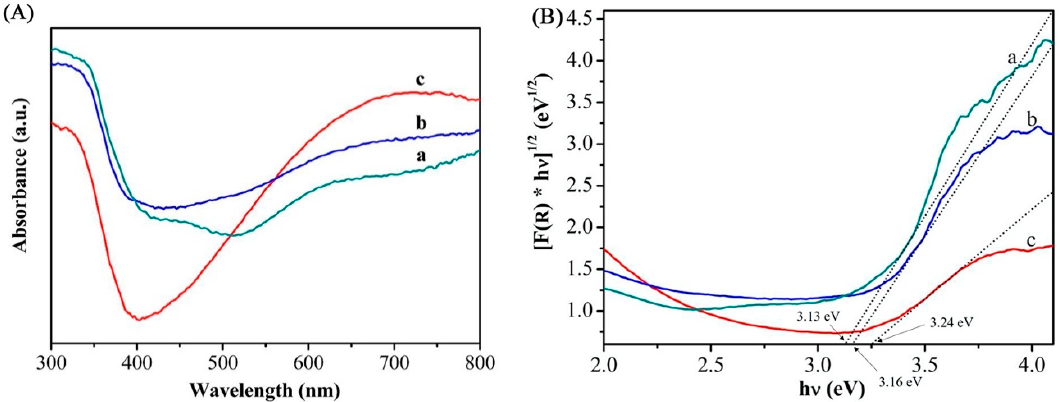
Figure 6. ( A )UV-Vis DRS and ( B ) ( α h ν ) 1/2 vs. h ν plots of Mo-TiO 2 nanotube array films with different Mo-doped concentration: (a) Mo1.0, (b) Mo0.5 and (c) Mo0, where α denotes absorption coef fi cient, h ν is the photon energy.